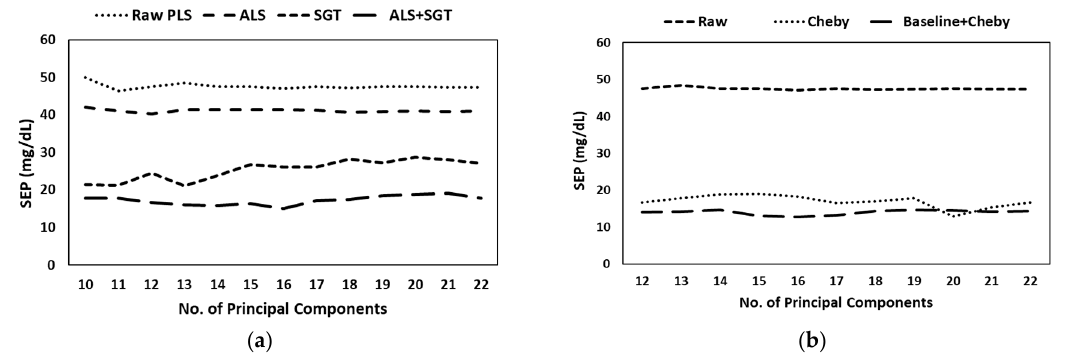
Figure 2. No. of latent variables vs standard error prediction for PLS Regression applied on ( a ) the spectra processed through different data correction methods ( b ) Raw spectra, Chebyshev filter spectra and baseline corrected + Chebyshev filtered